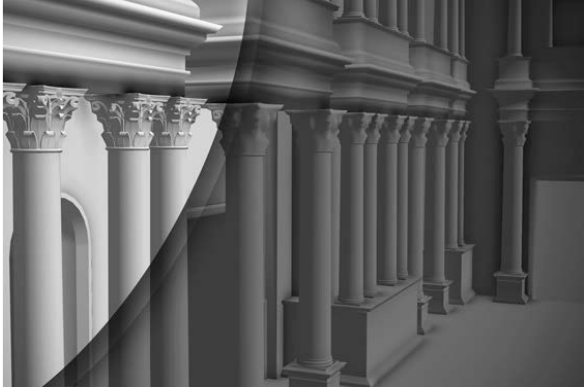
Figur e 9: 3D model optimized for use in